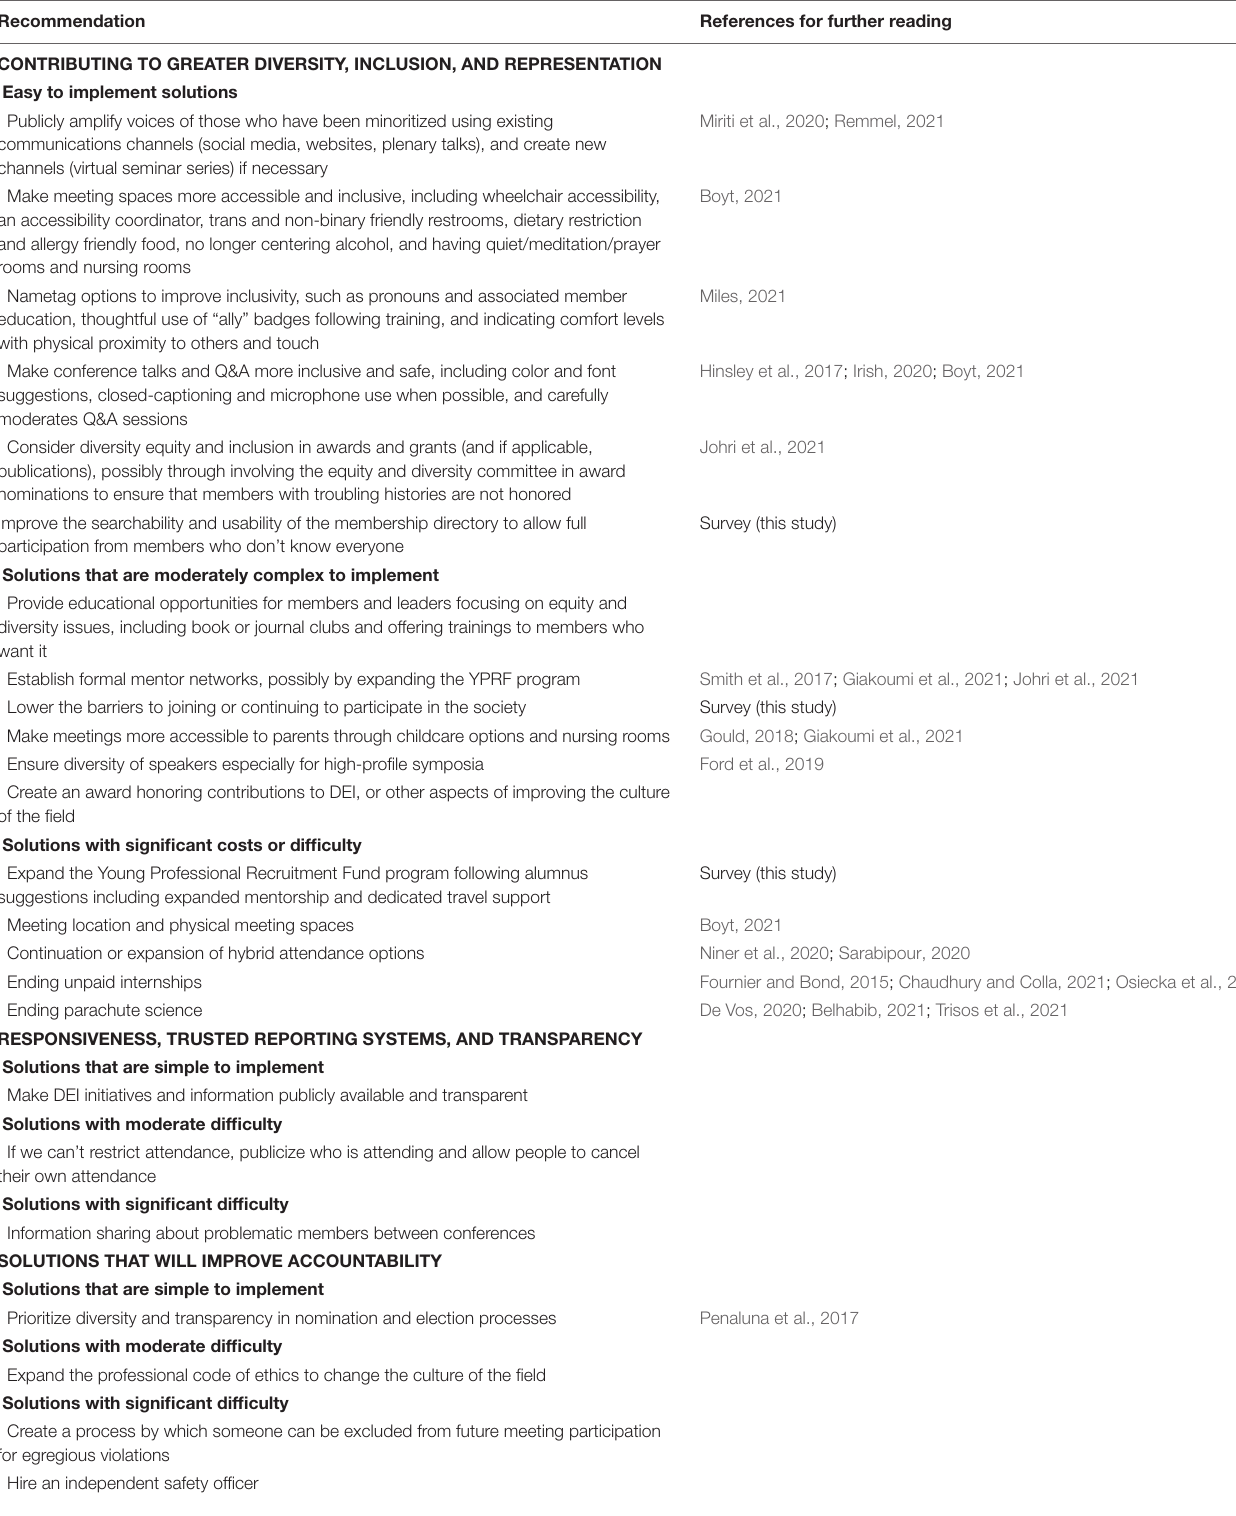
TABLE 1 | A summary of suggestions to improve the DEI issues surrounding